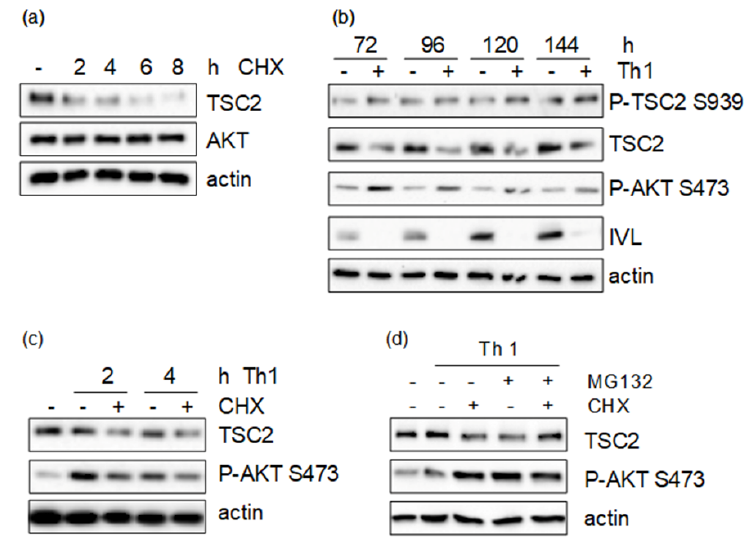
Figure 5. ( a ) HaCaT cells were treated with 10 µ g/mL cycloheximide (CHX) for the indicated time points. ( b ) Cells were treated with a Th1 cytokine cocktail (IL-1 β , IL-17A, TNF- α 20 ng/mL each) for the indicated time points. ( c ) HaCaT cells were serum-starved overnight and treated with Th1 cytokine and 10 µ g/mL cycloheximide (CHX) as indicated for 2 or 4 h. ( d ) Serum-starved cells were treated with Th1 cytokine mix, 10 µ g/mL cycloheximide (CHX) or 10 µ M MG132 as indicated for 4 h. Protein lysates were prepared and subjected to Western blotting, followed by detection of the indicated proteins.